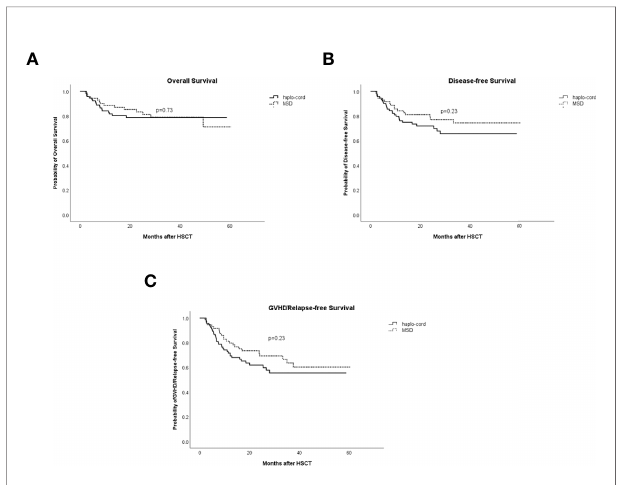
FIGURE 5 | Comparisons of survival rates in haplo-cord group and MSD group. (A) Overall survival (OS). (B) Disease-free survival (DFS). (C) GVHD/ relapse-free survival (GRFS). MSD, matched sibling donor; GVHD, graft- versus-host